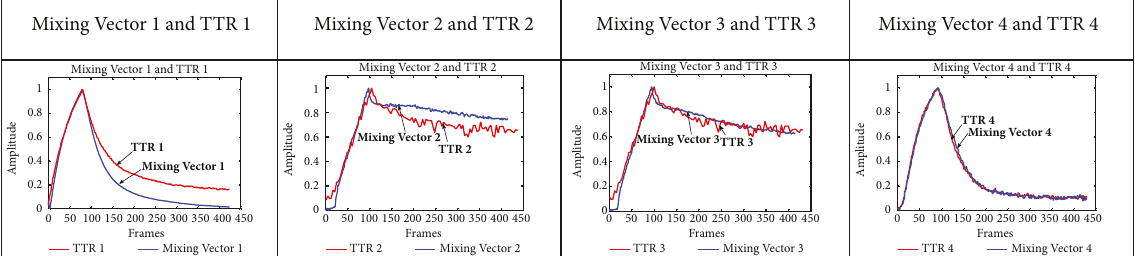
Figure 20: The normalized mixing vector 1, mixing vector 2, mixing vector 3, mixing vector 4, and 𝑇𝑇𝑅 1 , 𝑇𝑇𝑅 2 , 𝑇𝑇𝑅 3 , and 𝑇𝑇𝑅 4 .